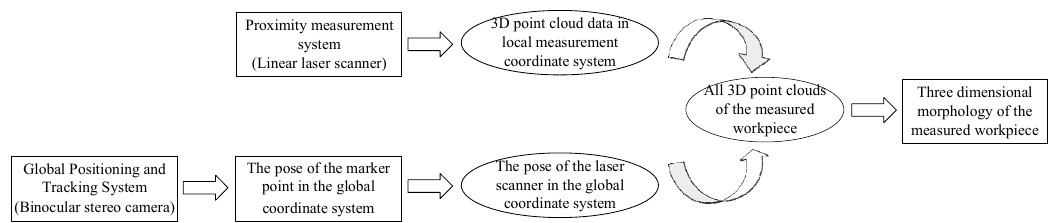
Figure 2. Flow chart of linear laser scanning measurement.